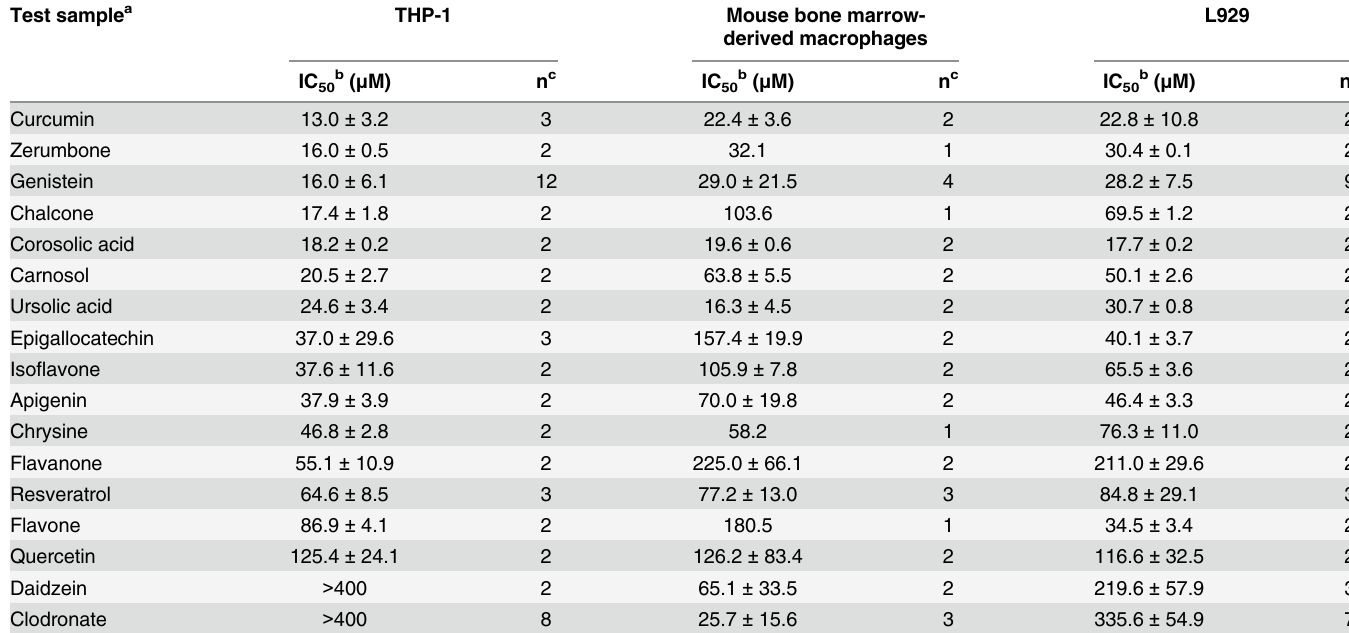
Table 1. Representative Compounds Showing Inhibitory Activities in Cell Proliferation Assays. Test sample a THP-1